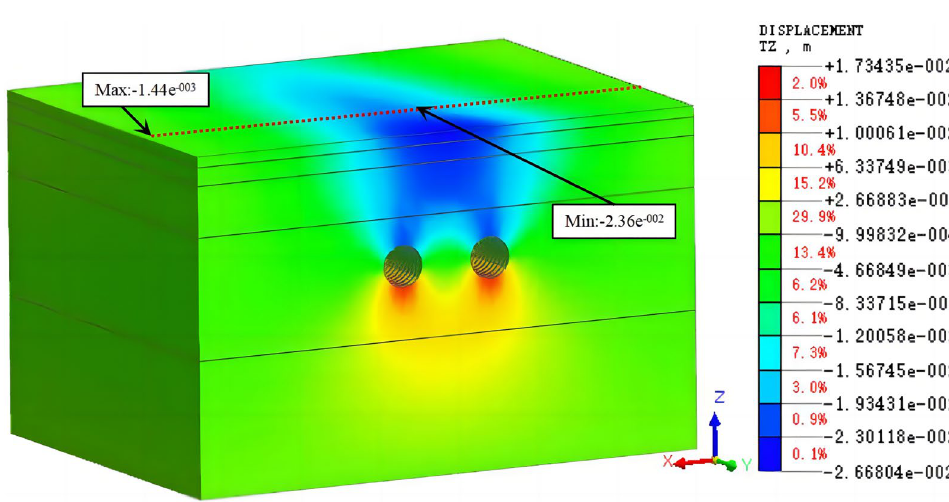
Figure 13. The cloud diagram of the vertical displacement for working condition 2 (double-line